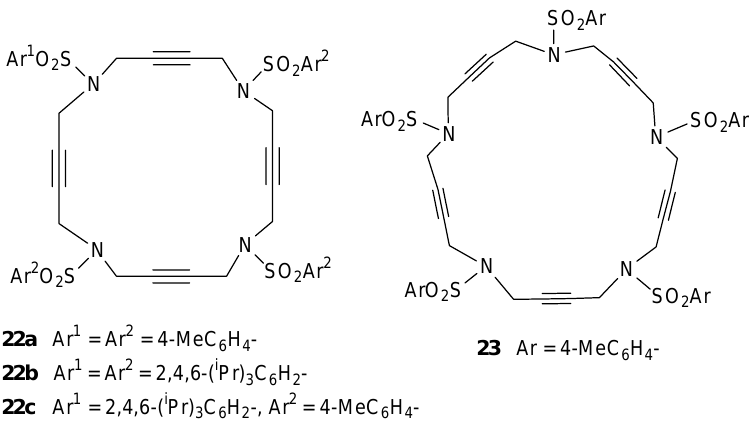
Figure 2. Tetra- and pentaacetylenic